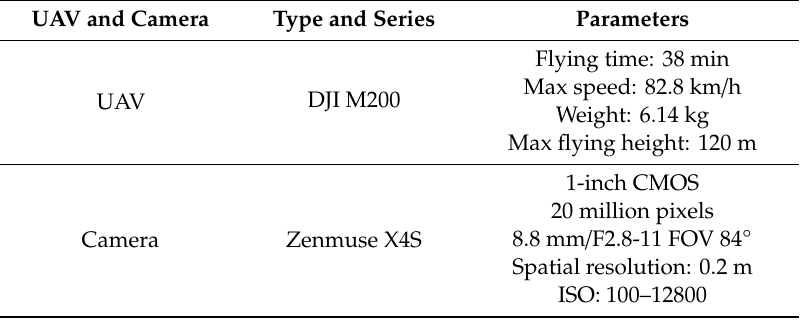
Table 1. The detailed information of the unmanned aerial vehicle (UAV) and camera